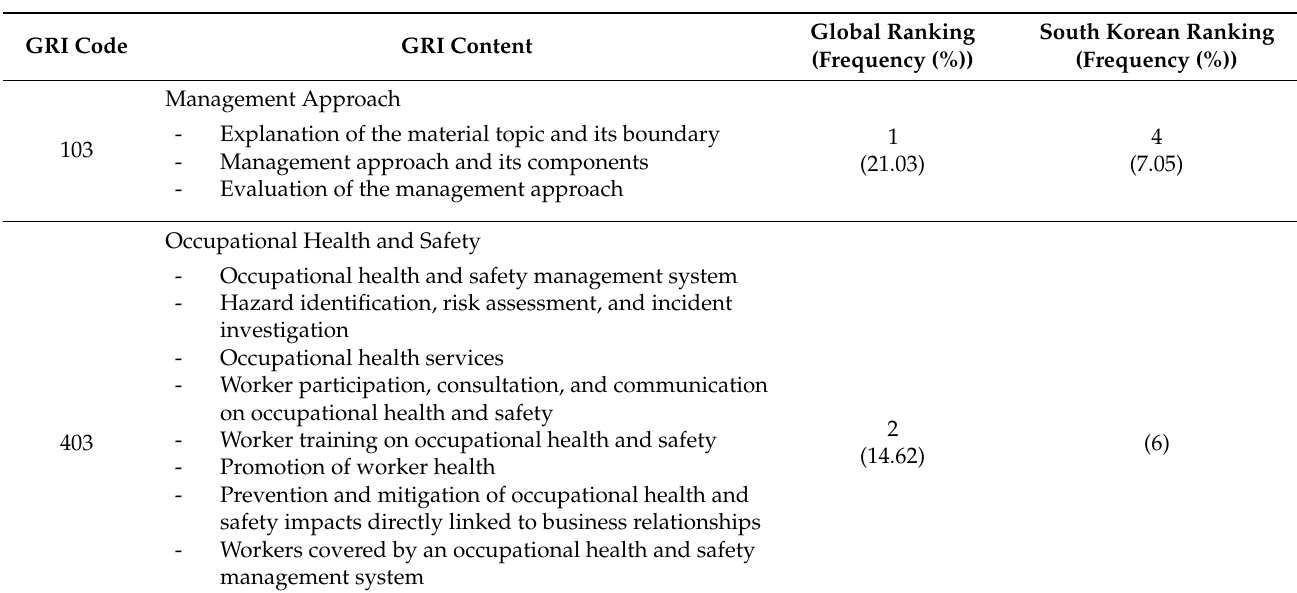
Table 9. Details of GRI codes with top frequencies among global and South Korean construction